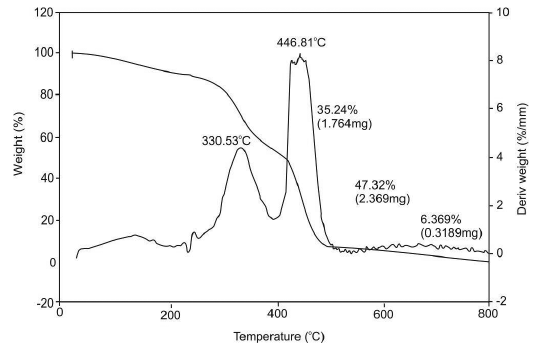
Figure 3. TGA scan of epoxidized resole